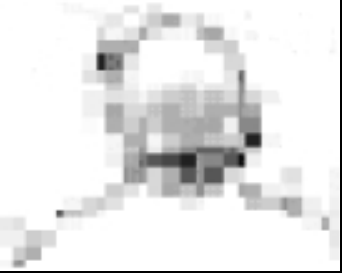
Fig. 7. A result of applying the frame difference method to a image of a human head.